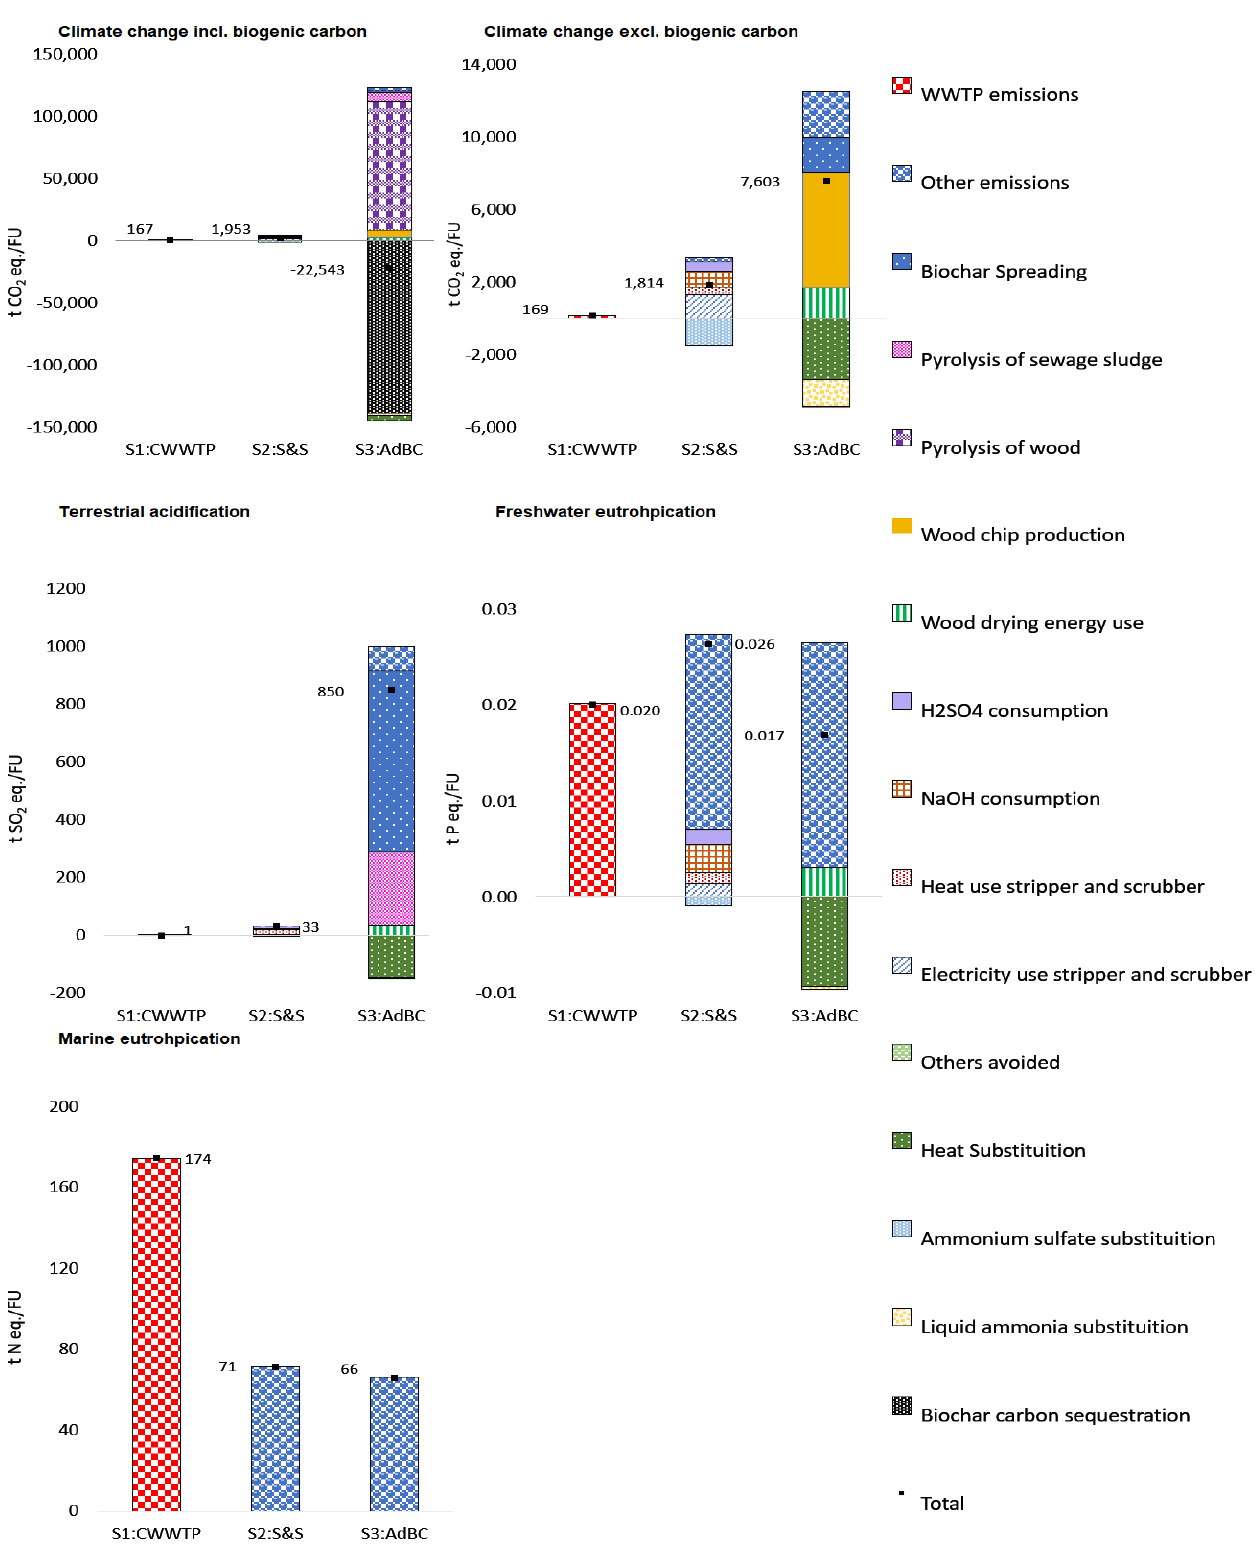
Figure 1. LCIA results for the selected impact categories in S1 (CWWTP), S2 (S&S), and S3 (AdBC).